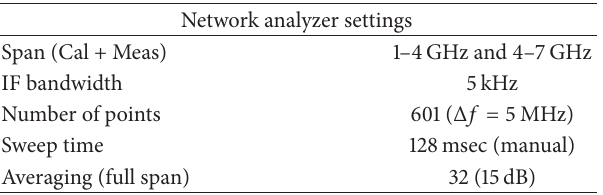
Table 7: Settings applied to the network analyzer during the measurement of the K2